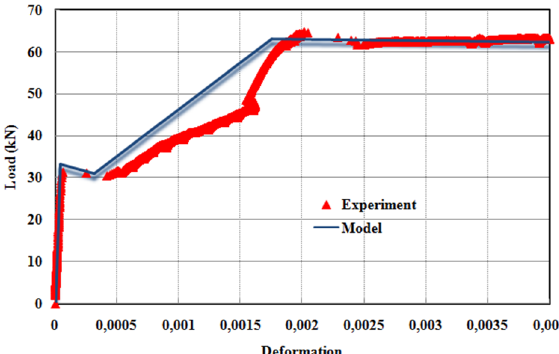
Figure 10. Force ‐ displacement curve for direct tensile test on concrete prism.